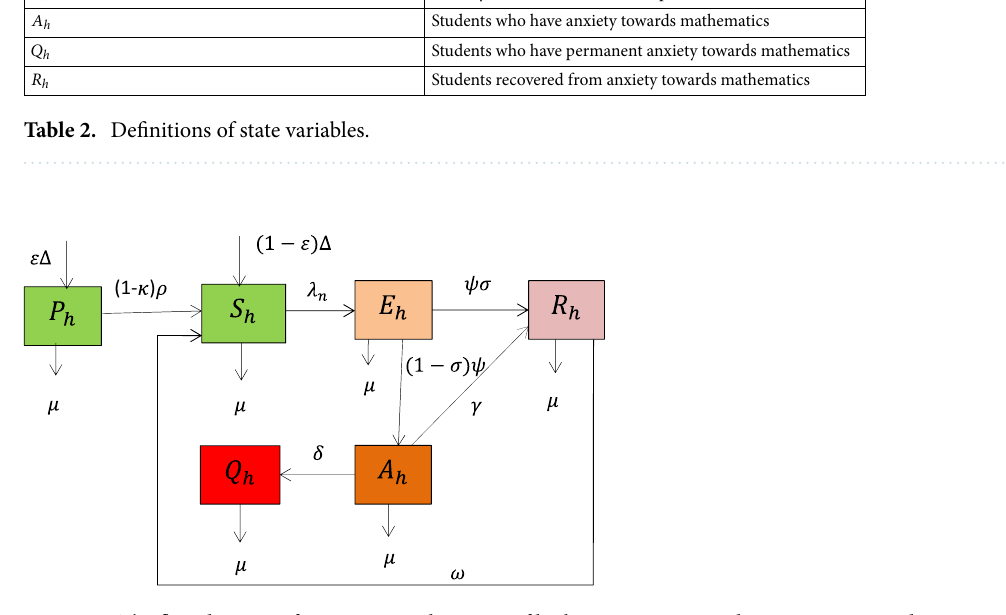
Figure 1. The flow diagram of transmission dynamics of higher institutions students anxiety towards mathematics where (cid:31) n is given in (Eq.